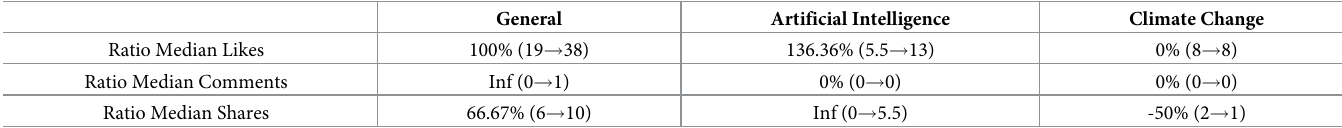
Table 7. (Facebook) percentage changes in terms of engagement with posts. The increase/decrease is reported within